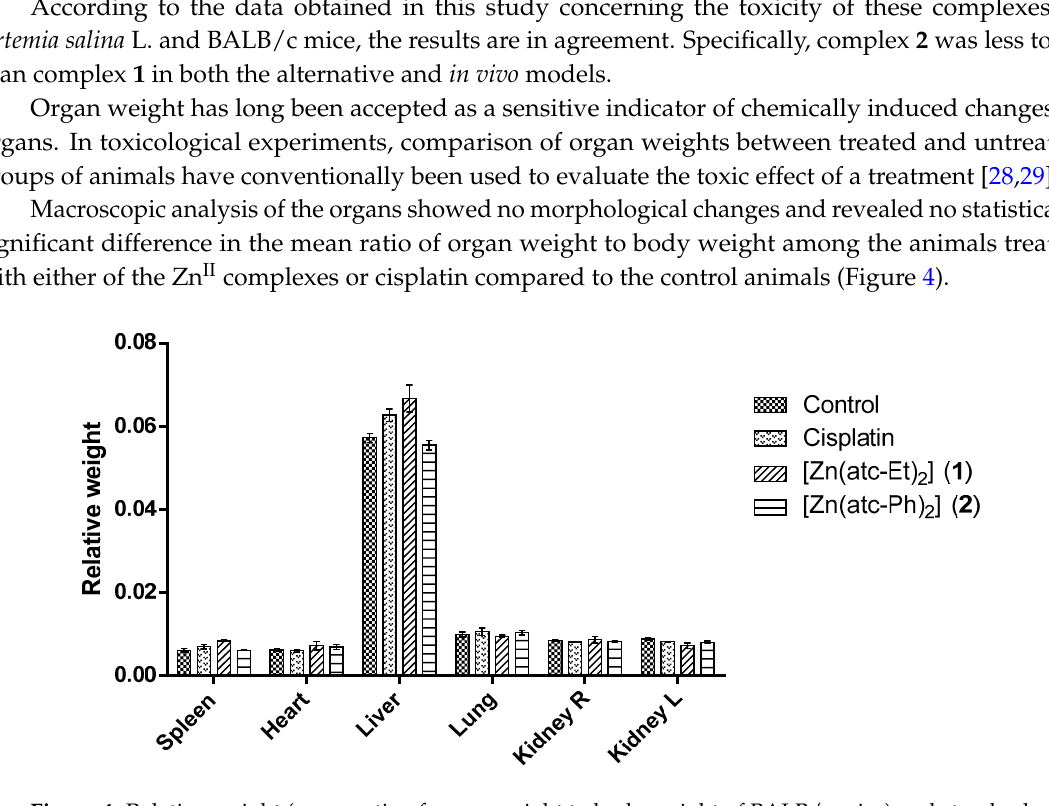
Figure 4. Relative weight (mean ratio of organ weight to body weight of BALB/c mice) and standard deviation (SD). R: right ; L: left